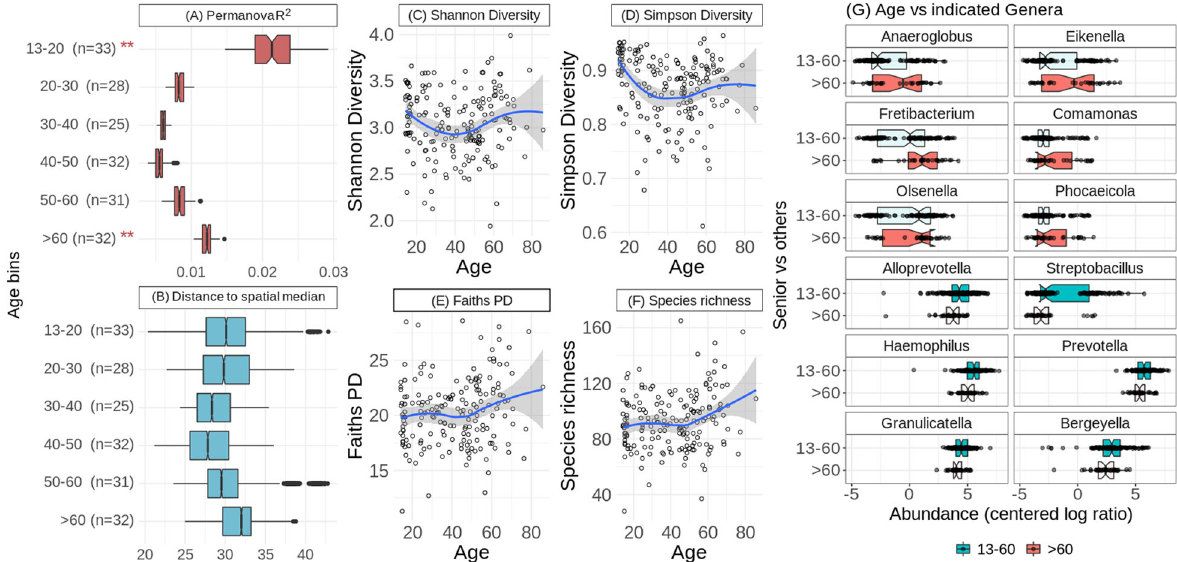
Fig. 1 Homogeneity, distinction of composition, and alpha diversity across age. A Boxes of the R² values are from the PERMANOVA tests run separately for each of the 100 subsamples. The n in both plots indicates the number of samples in a given age bin in each subsample. Red stars indicate the magnitude of the mean adjusted p-values for the PERMANOVA tests. The representation of p -values are represented with symbols as indicated in the following value intervals: 0 “ *** ” 0.001 “ ** ” 0.01 “ * ” 0.05, Not signi fi cant. B Boxes for the distances to the spatial median represent those distances of each sample from the spatial median of its particular age bin, as calculated by the betadisper function. The spatial medians for age bins and the associated ANOVAs were run separately for each of the 100 subsamples, but the boxes here display all such distances for each age bin. C – F Tests of the four alpha diversity measures (Shannon, Simpson, Faith ’ s PD, species richness) were also run with those same 100 subsamples, using age as a continuous value, and the statistical values are summarized in Table 1. The four respective scatter plots here display only the values from one of those subsamples to give a representative depiction of the trend (the same subsample is used for all four), with age (in years) along the x -axis. G Genera that increase with age tend to be found at lower abundances while those that decrease with age tend to have greater abundances. Boxes display the distributions of abundances of genera (samples were divided into two age groups merely to generalize the tendencies across age: 13 – 60 years old, or older than 60). The fi rst six genera were those that increased with age (the red boxes for >60 year old individuals are highlighted), and these have notably low abundances in general, while the latter six genera, which decreased with age (the blue boxes for 13 – 60 year old individuals are highlighted), tend to be found at high abundance, with the exception of Streptobacillus , which is more